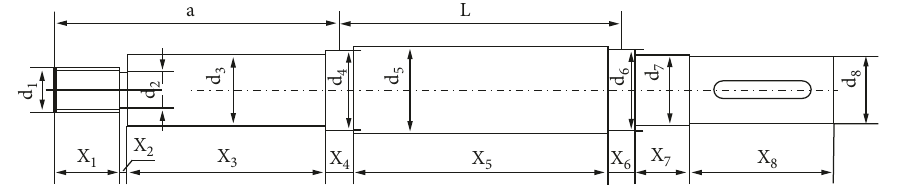
Figure 25: Schematic diagram of structural dimensions of the pump shaft. Table 11: Structure and dimension of the pump shaft.